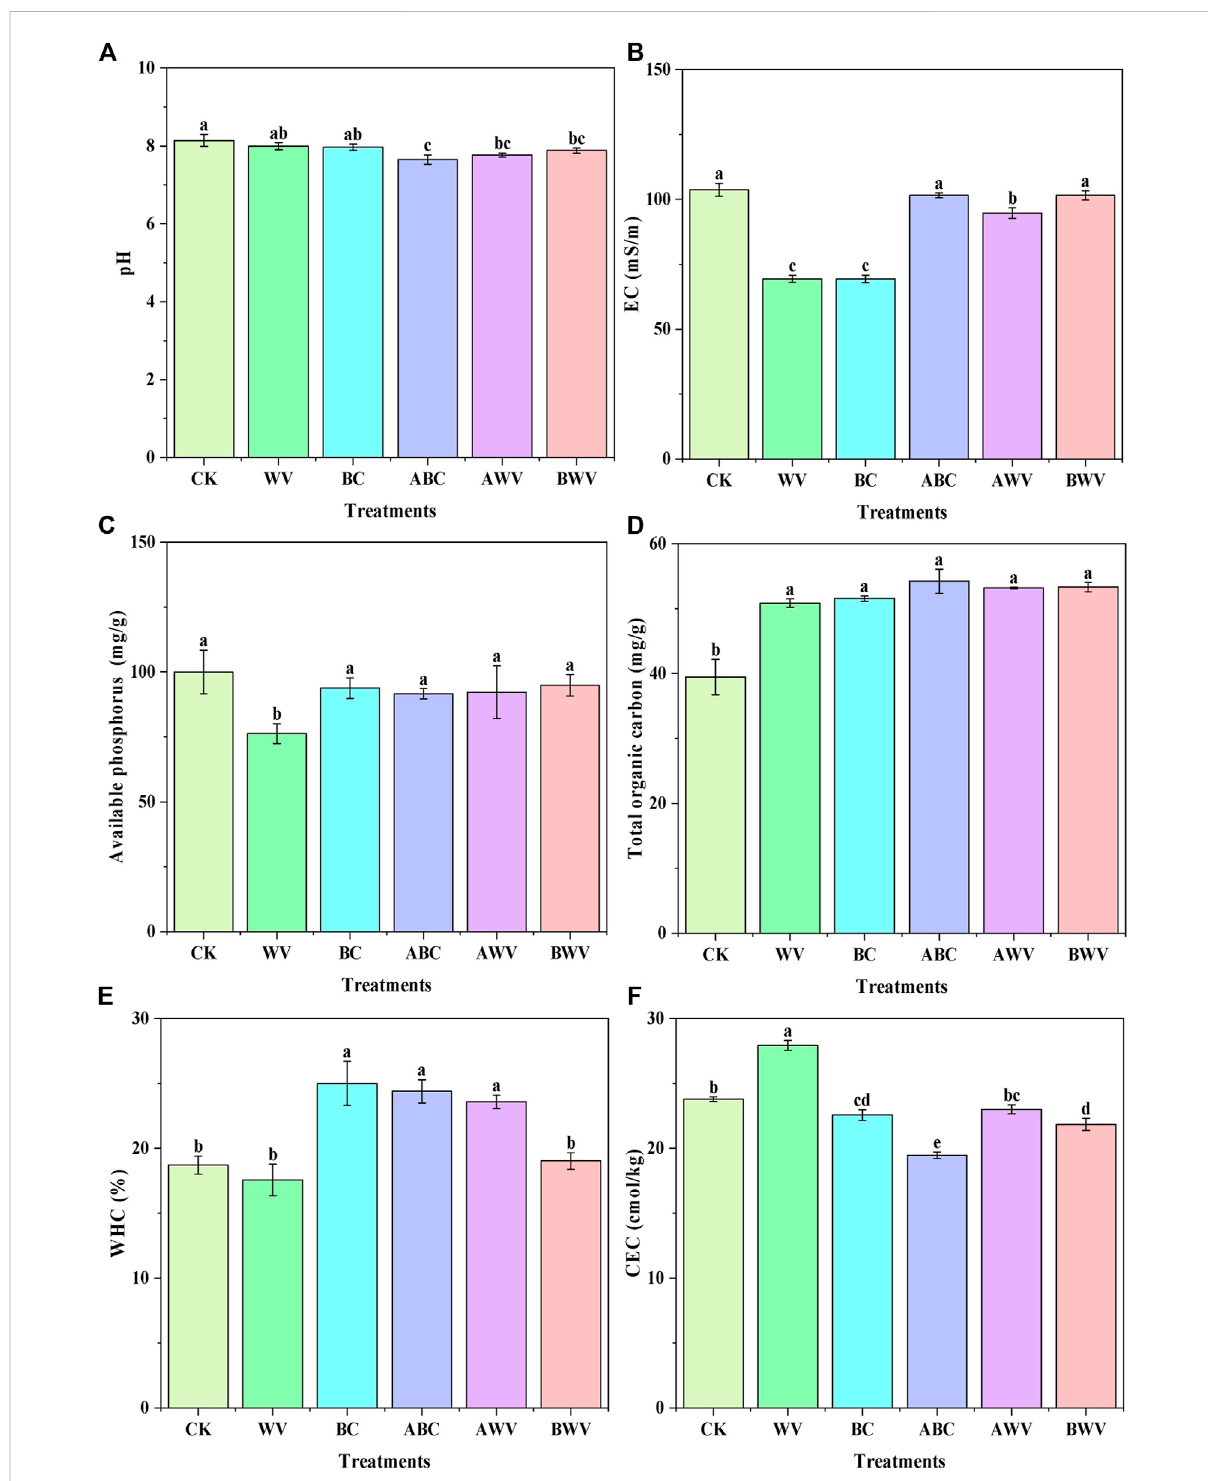
FIGURE 3 Transformations in pH (A) , electrical conductivity (B) , available phosphorus (C) , total organic carbon (D) , water-holding capacity (E) , and cation exchange capacity (F) in different treatments (CK, WV, BC, ABC, AWV, and BWV) of the coastal saline − alkali